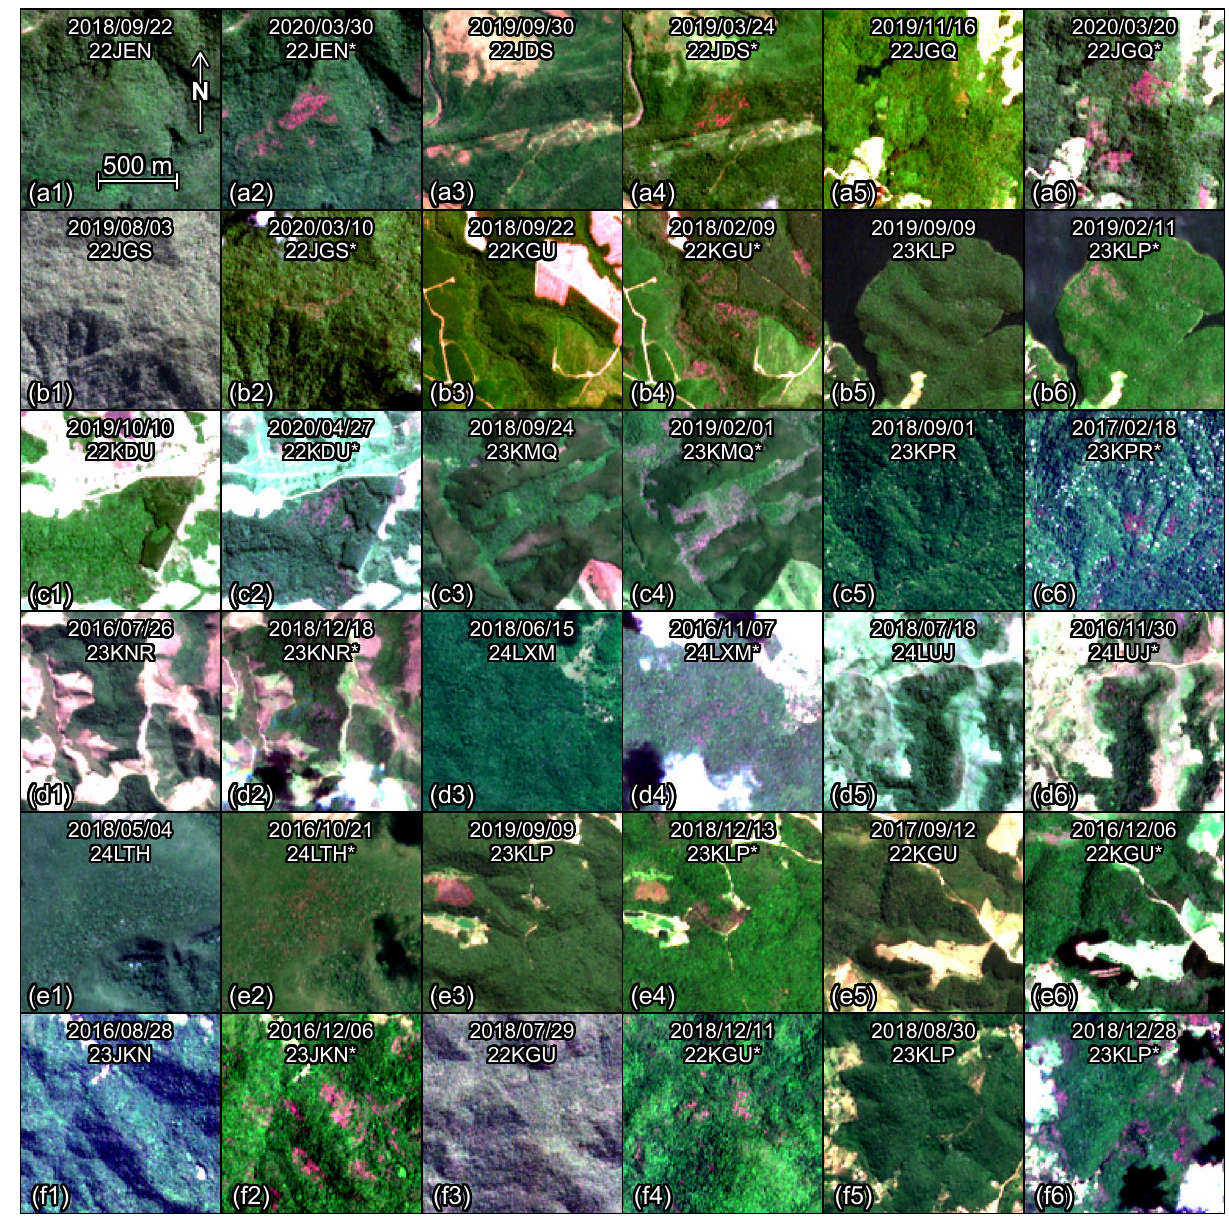
Figure 4. Sentinel-2 image subsets with Pleroma trees detected by the model (Panel I). To ease the visual detection of the pink/magenta trees, one image taken outside the blossom period and one taken within the blossom period (denoted with an *) are given for each region of detection. The dates and tile names of the Sentinel-2 images are indicated on the June solstice. The latter was almost entirely seen in pixels representing area far from the Atlantic coast on the eastern side of the Atlantic Forest. During and around the September equinox, only a few isolated and clustered areas blossomed in a region between 18°–20°S and 39°–43°W and on the eastern side of the Atlantic Forest. The median duration of flowering was 80 days days (95% confidence interval—from percentile 2.75 to 97.5—of 41 to 168 days). One peak occurred in 76.2% of the pixels, two peaks in 22.8%, and more than two peaks in a marginal 1% (Fig. 7b). The pixels with two flowering peaks per year showed a significantly higher number of detections per year than the pixels with only one peak per year (median of 8.5% and 6.1% of cloud-free images, respectively; Wilcoxon rank sum test p-values <2.2e-16). In the regions with two flowering peaks, two populations of Pleroma existed that flowered at different times (Fig. 8a–l) and were also spatially separated (mainly visible in Fig. 8c,d). Even with a trained eye, it can be difficult to spot the pink flowering trees (for example Fig. 8i–l), because the pink or magenta forest patches are small and because some other land cover types, such as bare ground, can have a pink hue. While visually observing changes between two pictures at different times is usually necessary to find and confirm the presence of pink flowering trees, the algorithm was able detect the flowers with one image only. Also, note that in the Figs. 4, 5, 6 and 8 the image bands were adjusted by minimum-maximum stretching to